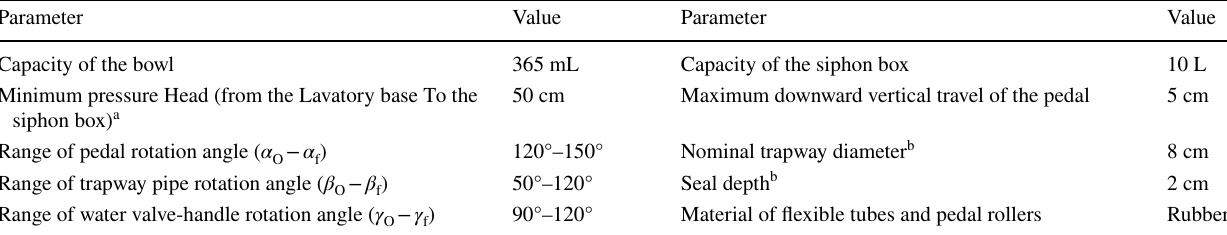
Table 1 Specifications of the experimental apparatus